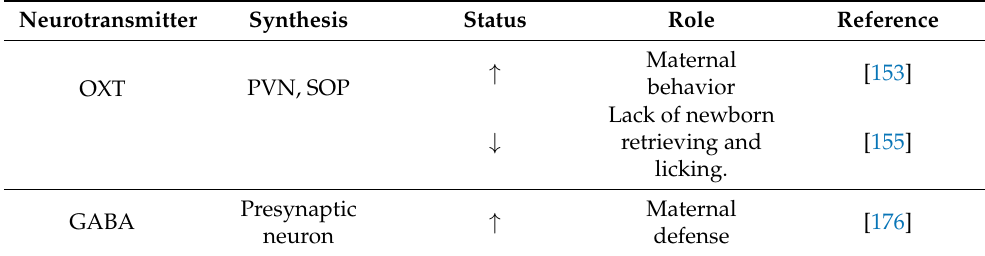
Table 2. Main neurotransmitters involved in mother–young